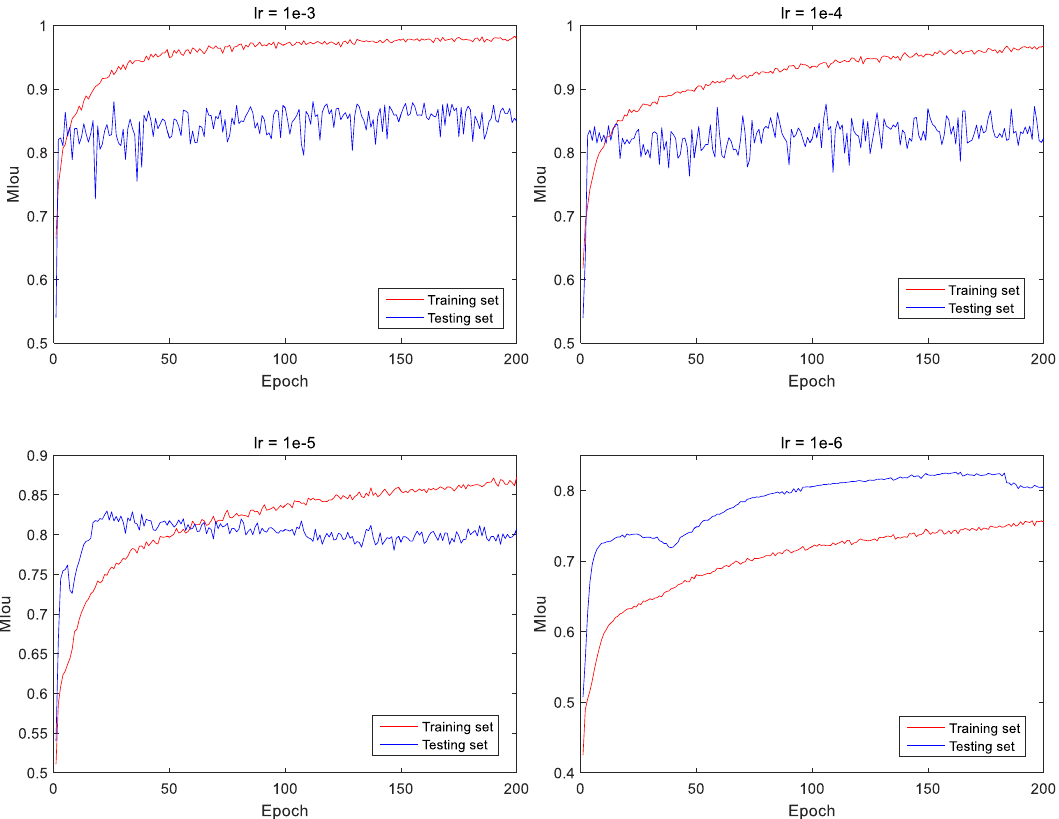
Figure 10. Mean intersection over union (MIoU) curves of training and validation datasets under four different learning rates.